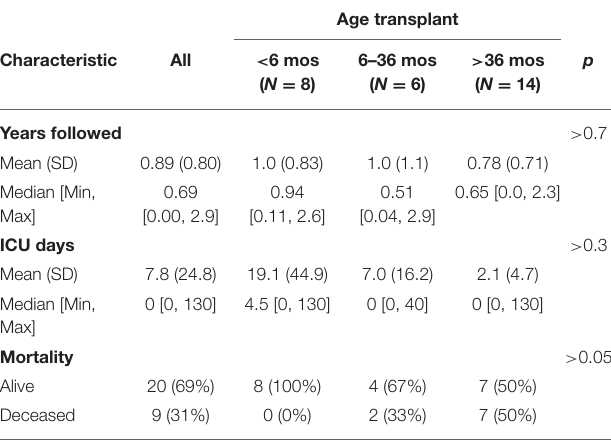
TABLE 2 | Age of transplant (HSCT), duration of follow-up, and outcomes of ICU days and